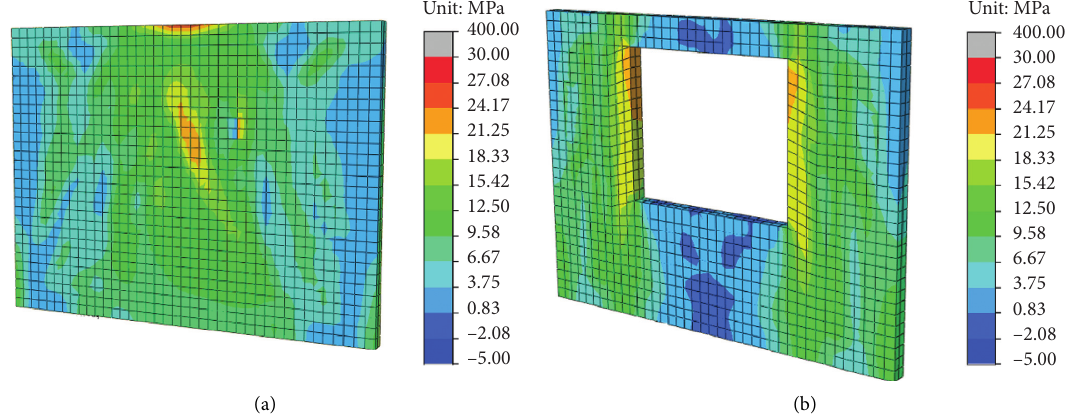
Figure 17: The stress nephograms of the walls: (a) without a hole and (b) with a